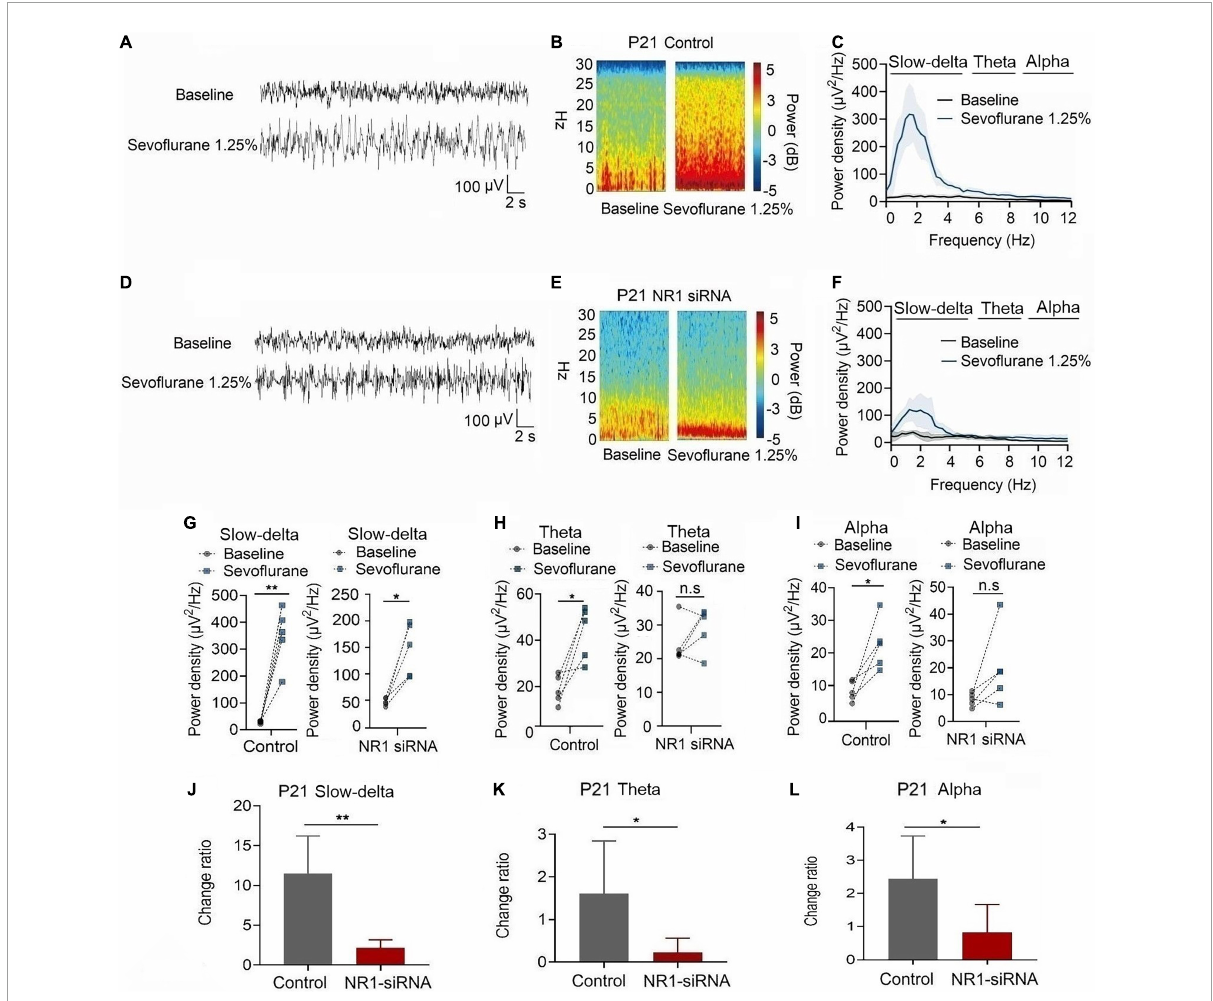
FIGURE8 Knockdown of NR1 inhibited the enhancement of slow-delta, theta and alpha oscillations in P21 rats. (A,B,D,E) EEG and it’s power spectrogram of P21 rats under sevoflurane in the control group and NR1-siRNA group. (C,F) EEG power spectral density of P21 rats under sevoflurane in the control group and NR1-siRNA group ( n = 5). EEG power spectral density. (G–I) The change of power density of slow-delta, theta and alpha oscillations of P21 rats under sevoflurane in the control group and NR1-siRNA group ( n = 5). (J–L) The change ratio of the power density of slow-delta, theta and alpha oscillations of P21 rats under sevoflurane ( n = 5). Data are presented as mean ± SD. n.s., not significant; * P < 0.05, ** P < 0.01 by paired t -test (G–I) and unpaired t -test (J–L)